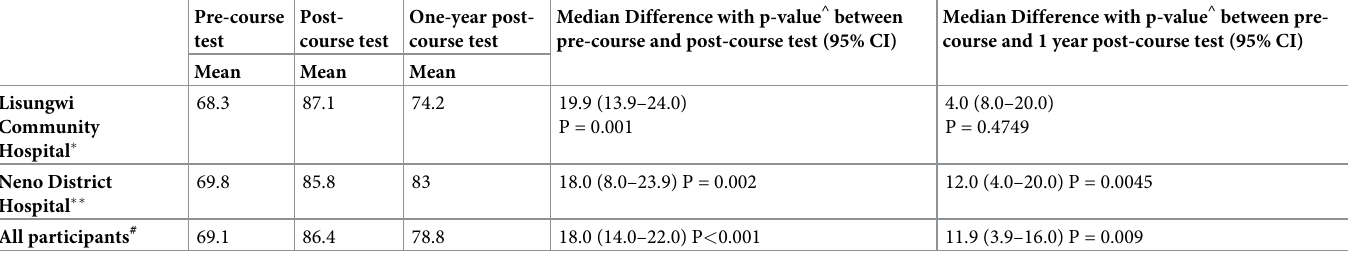
Table 2. Pre-course, post-course and one-year post-course mean test scores with median difference in Lisungwi Community Hospital and Neno District Hospital. Pre-course